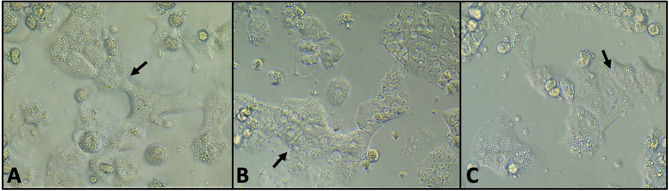
Phase contrast microscopy of untreated hepatocytes at 24 h (A), 48 h (B), and 72 h (C) of incubation. The cells maintained cell-to-cell adhesion (arrows) and the polygonal morphology characteristic of hepatocytes.